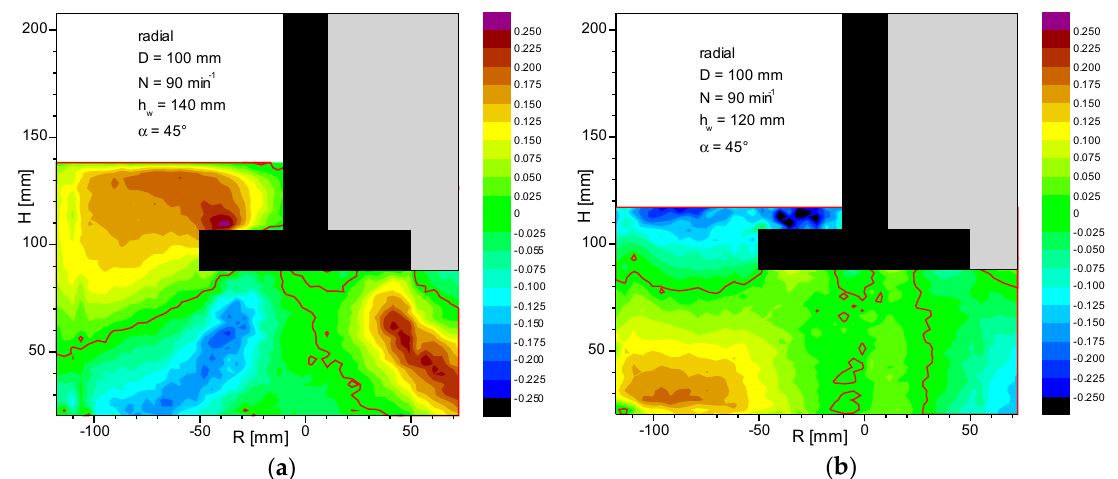
Figure 10. Radial velocity maps: ( a ) h w = 140 mm; ( b ) h w = 120 mm.